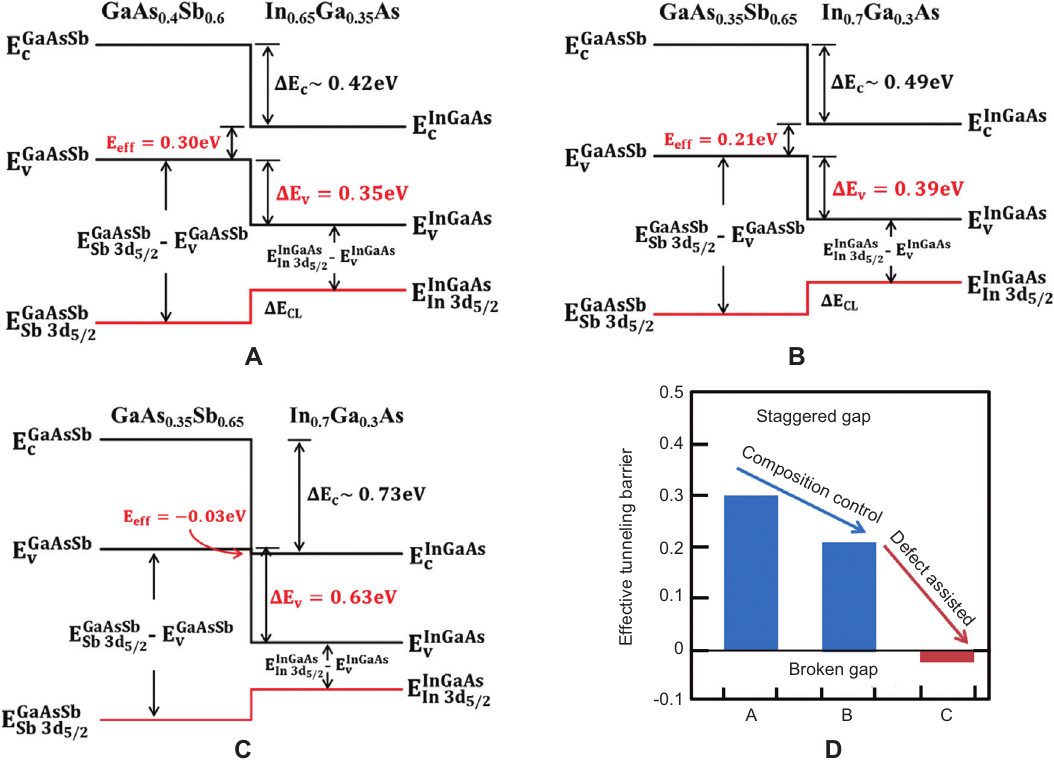
Figure 31 Schematic energy band diagram of (A) structure A, (B) structure B, and (C) structure C. A type-II staggered band line-up with positive effective tunneling barrier height of 0.30 eV and 0.21 eV was determined at the heterointerface of structures A and B, respectively, whereas a broken band line-up with negative tunneling barrier height of -0.03 eV was found at the heterointerface of structure C. (D) The histogram summarizes the effective tunneling barrier height and the corresponding band alignment types of these structures. Reprinted from Ref. [13], with permission, from the American Institute of Physics, copyright (2012), AIP Publishing